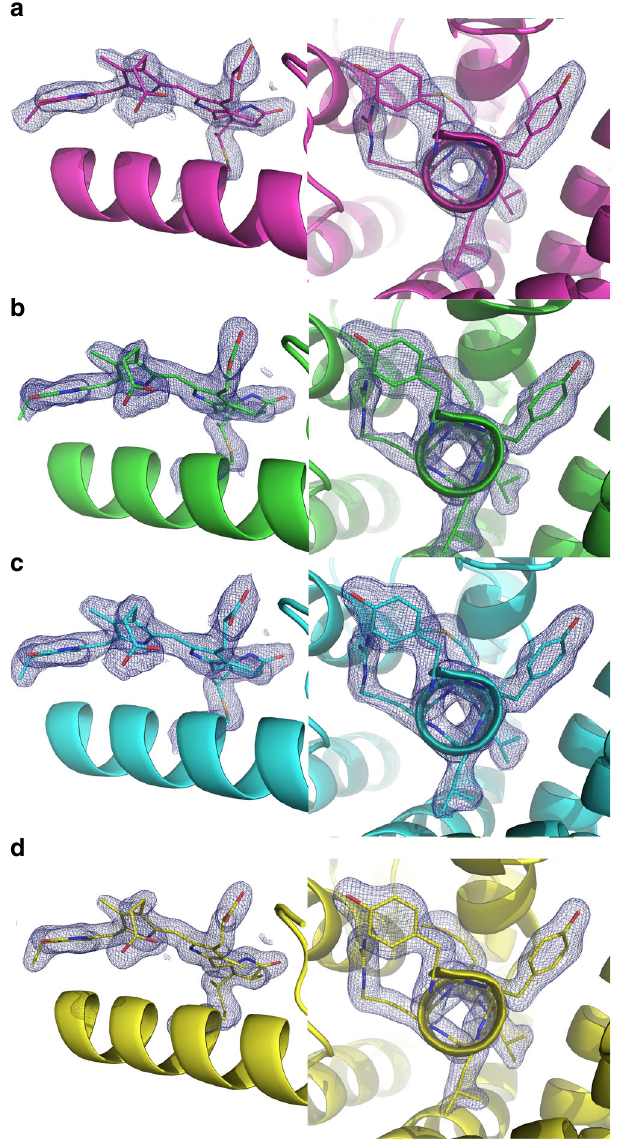
Fig. 6 Comparison of exemplary electron density maps of phycocyanin (2mF o − DF c at 1.5 σ level) showing one of the phycocyanobilin molecules present in the structure (left) and a view along residues 90 – 95 of α -helix 6 (right) obtained by pink-beam serial crystallography at a synchrotron ( a – c ) and with serial femtosecond crystallography ( d ). a The electron density of dataset Phyco_A1 obtained from the measurement of 45 diffraction images using the APS single bunch. b The electron density of dataset Phyco_B obtained from the measurement of 205 diffraction images using the APS single bunch. c The same regions obtained from 52 diffraction images using a longer exposure time of 3.68 μ s per crystal. d Structure 4ZIZ from the PDB based on 6679 single shot diffraction images collected at